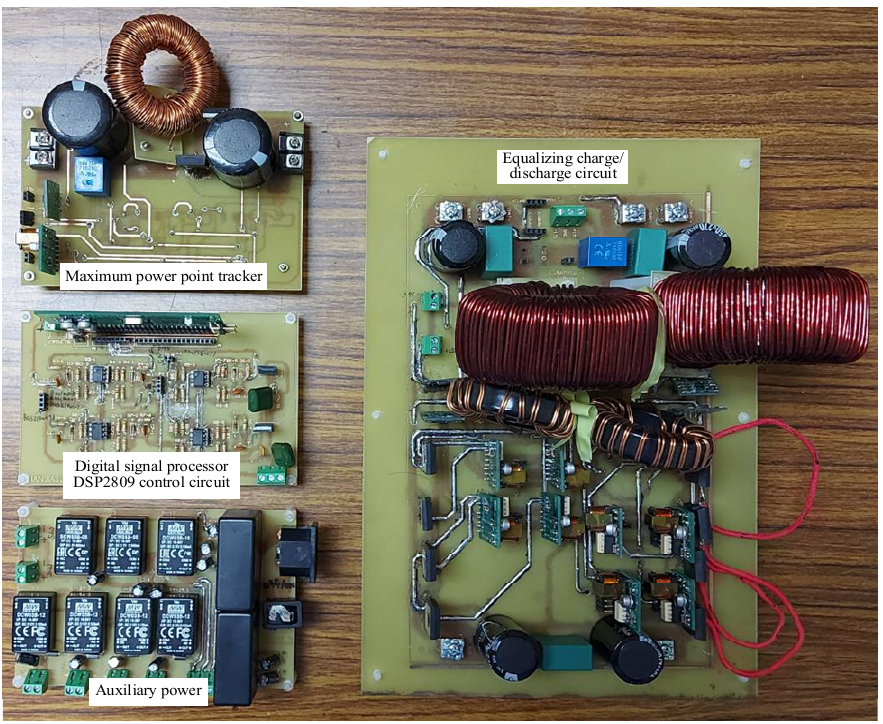
Figure 12. Physical circuit for the PMA combined with the battery equalizing charge/discharge con- trol.